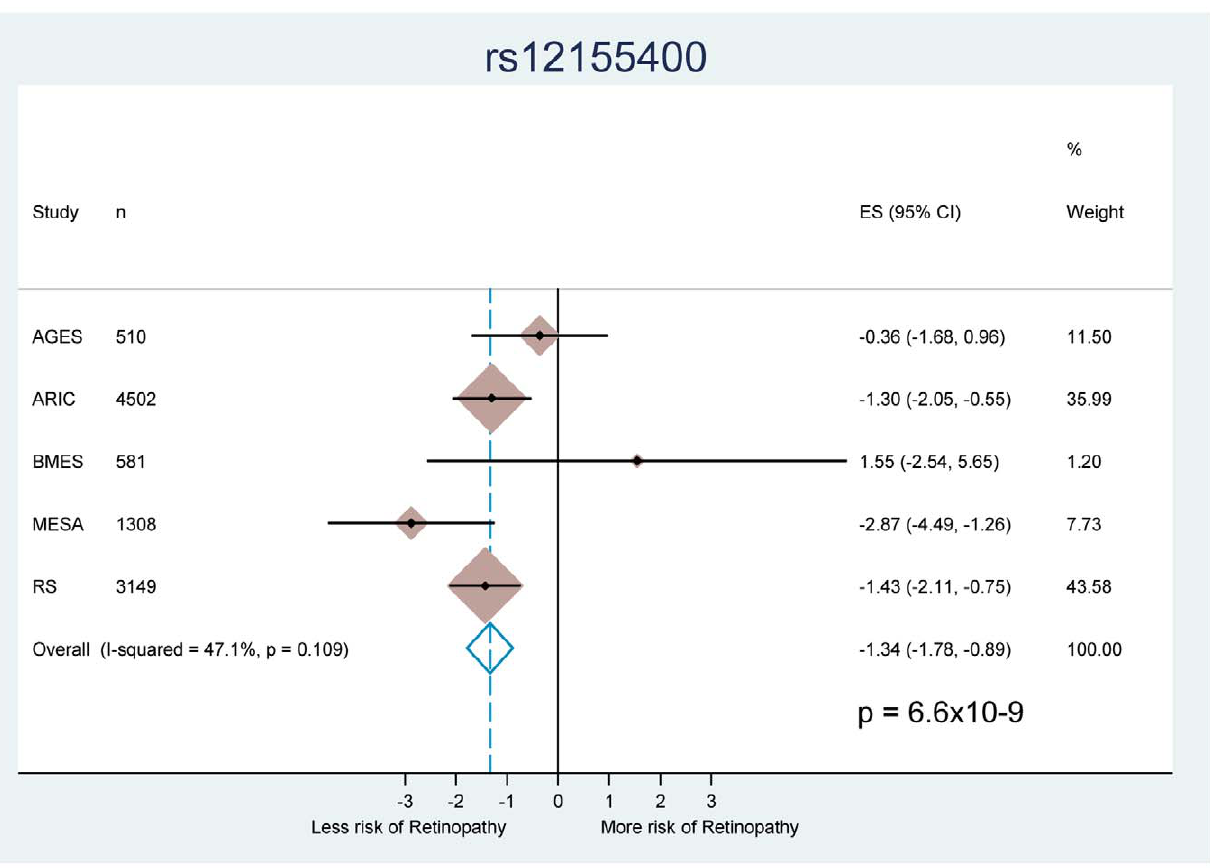
Figure 3. In addition, two other SNPs at this locus in linkage disequilibrium with rs10486302 just missed reaching gene-wide significance, rs723296 (p= 6.2 6 10 2 4 , r 2 = 0.79) an imputed SNP